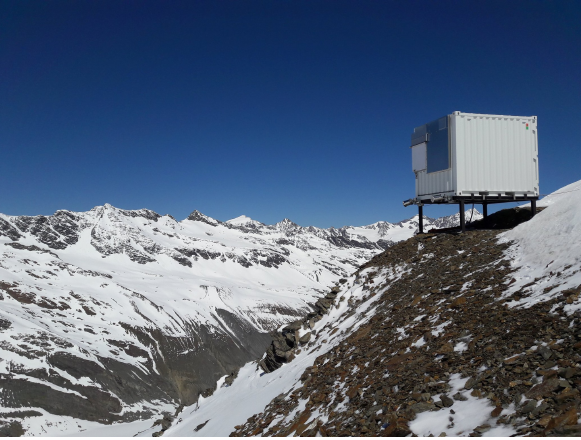
Figure 2. The final position of the TLS container Im Hinteren Eis , looking in northern